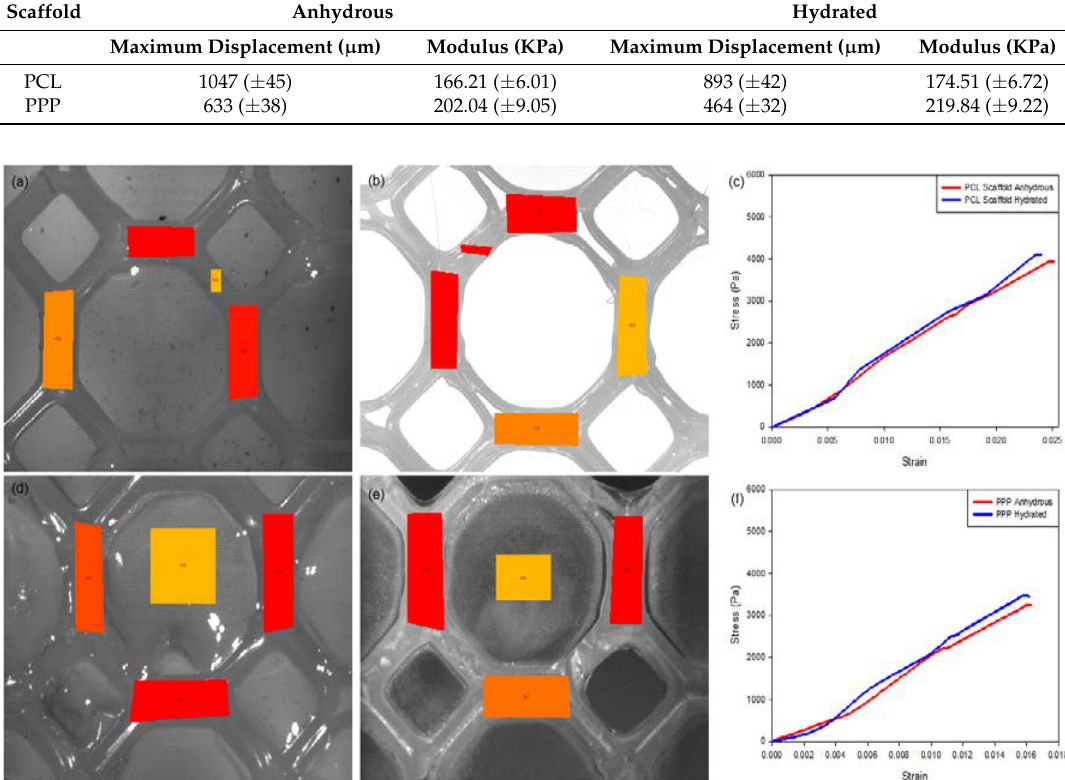
Figure 8. Strain-tracking images of ( a ) the hydrated PCL and ( b ) the anhydrous PCL. ( c ) Strain graph of the PCL scaffold. Strain-tracking images of ( d ) the hydrated PPP and ( e ) the anhydrous PPP scaffold. ( f ) Strain graph of the PPP scaffold. Degree of strain exerted at specific points on the scaffold is represented in red (greatest), orange (intermediate) and yellow (least) strain.